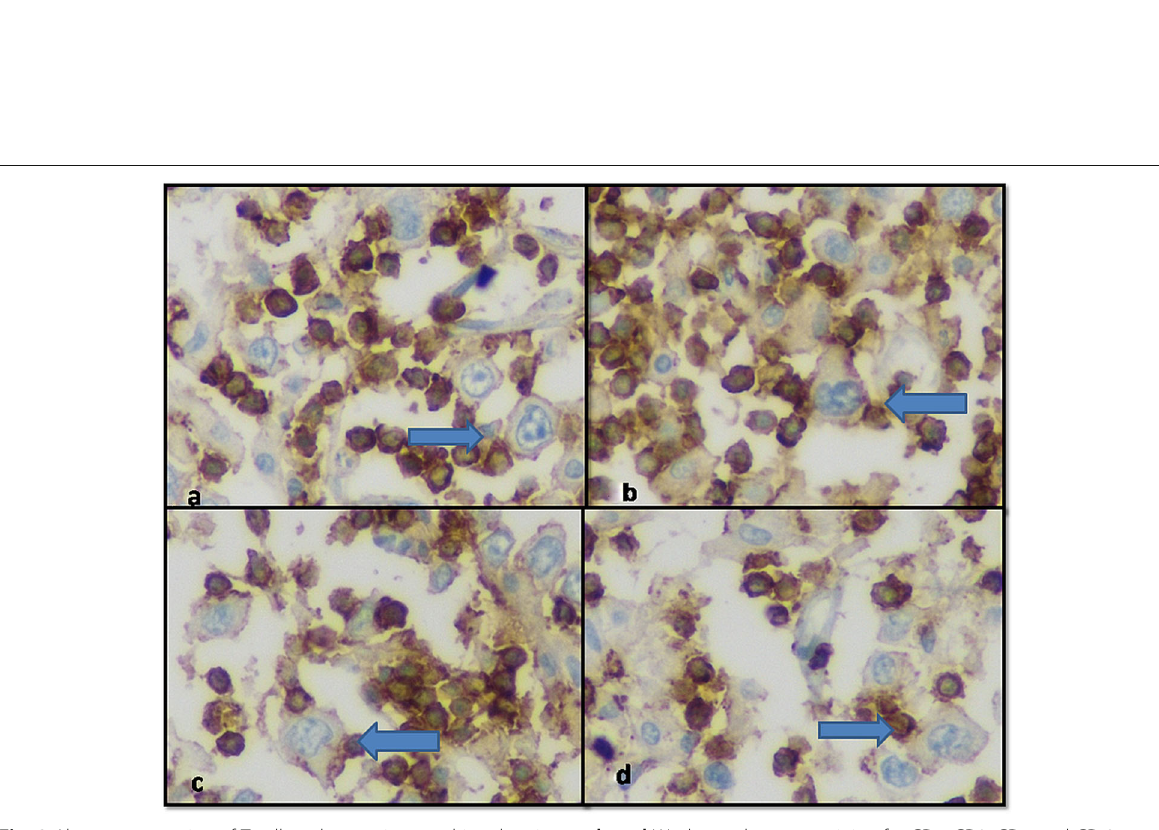
Fig. 3 Aberrant expression of T cell markers on immunohistochemistry. a , b , c , d Weak membranous staining for CD4, CD2, CD7, and CD 3 respectively in the large tumor cells